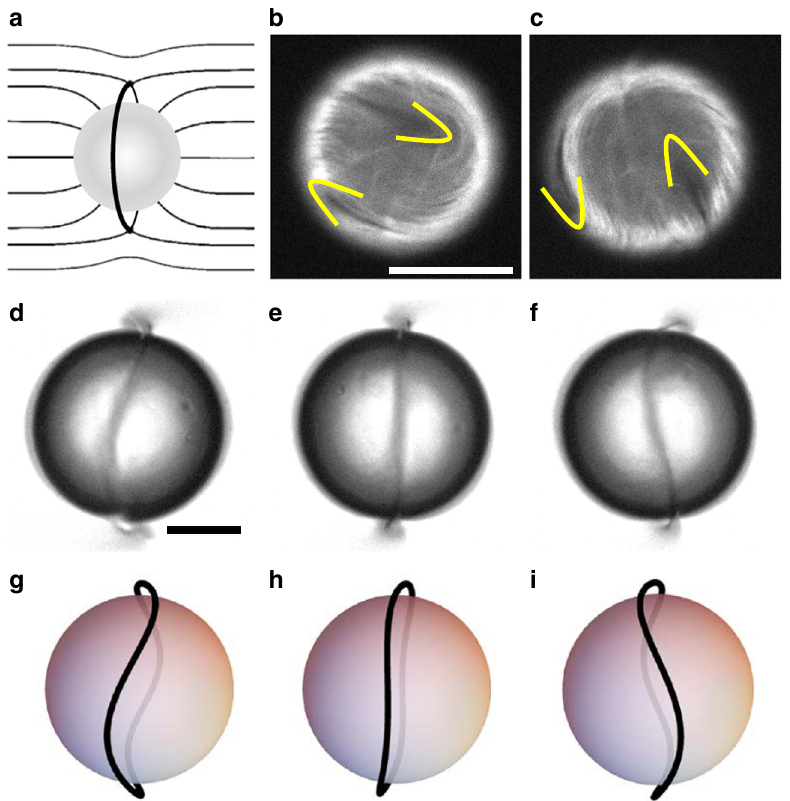
Fig. 6 Active shells embedded in a nematic liquid crystal. a A spherical inclusion in a homogeneous nematic liquid crystal leads to the formation of an annular disclination (Saturn Ring). b , c Fluorescence micrographs showing the evolution of an active nematic spherical shell with four + 1/2 defects (two visible at a given time), marked with yellow contours. d – f Bright fi eld micrographs with the oscillations of the Saturn Ring that has formed around an active shell. g – i Sketches showing the structure of the Saturn Ring in the micrographs ( d – f ). Scales are 20 μ m 111 . (Adapted with permission from